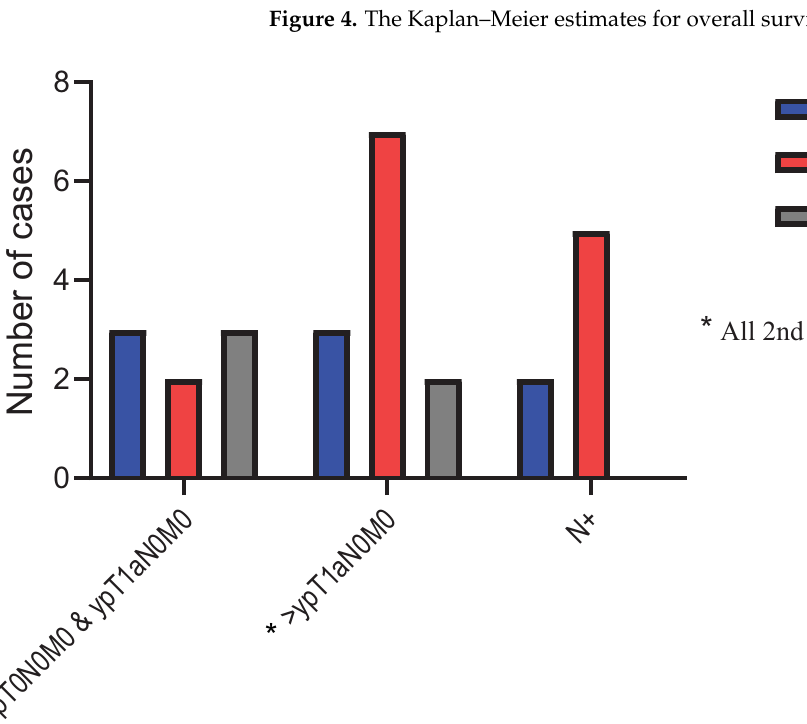
Figure 5. Post treatment signet ring cells (SRC) percentage distribution in Low-SUV